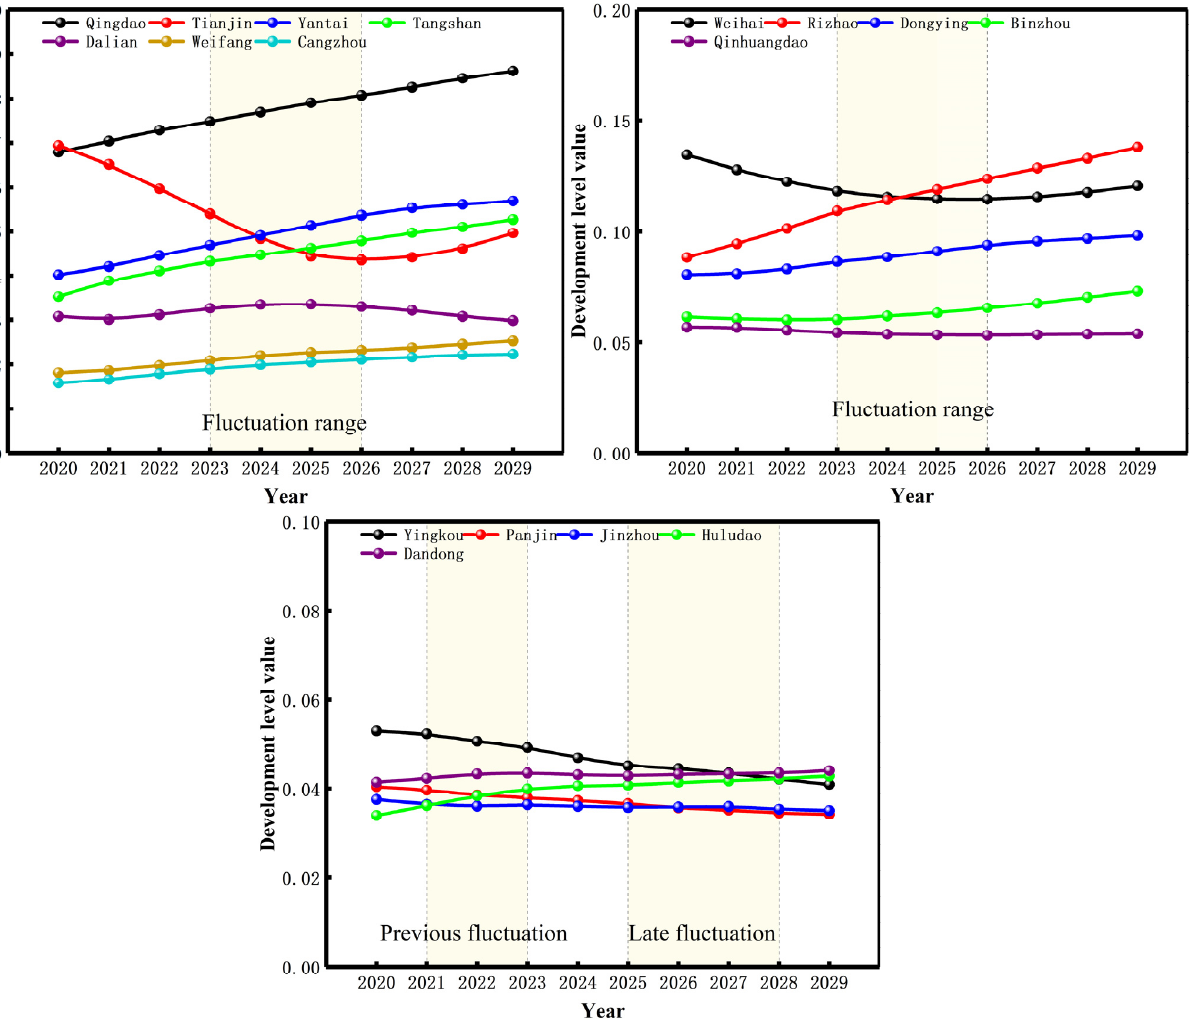
Figure 8. Prediction value of the integration capacity of each city in the Bohai Rim (2020–2029). Source: own study.